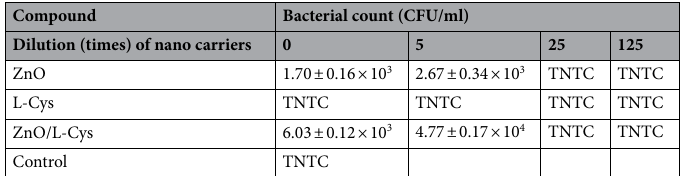
Table 4. Comparison of antibacterial activity of different nanocarriers on bacterial growth inhibition after 6 h incubation. TNTC too numerous to count.